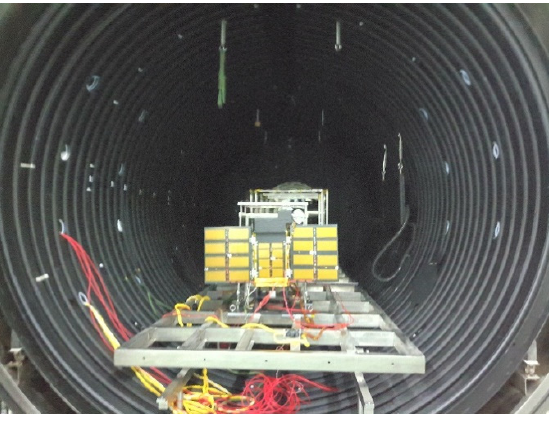
Figure 14. Testing site of Luojia 1-01.